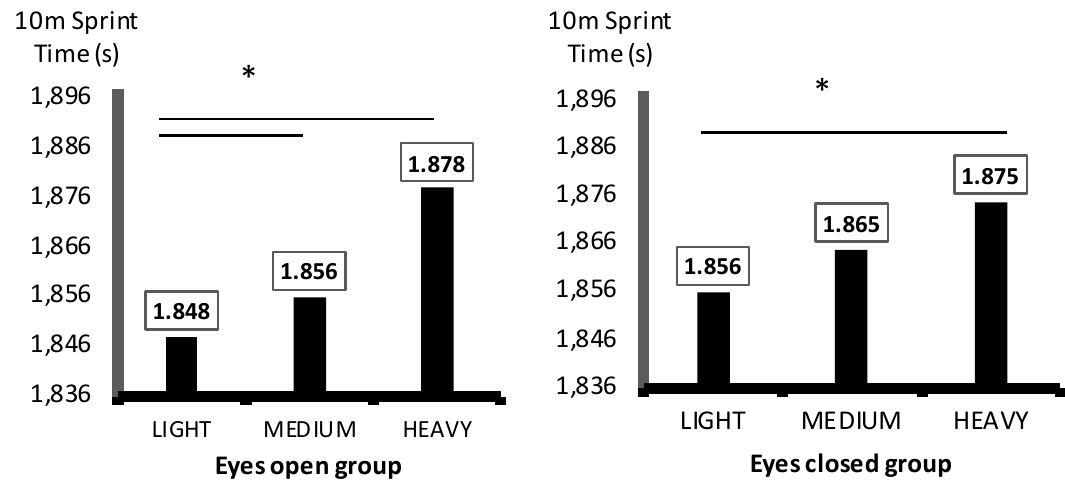
Figure 2. 10m sprint values of eyes open and eyes closed group with 3 different shoe weights. Asterisks mark significant differences between shoe conditions (p<0.01). s: